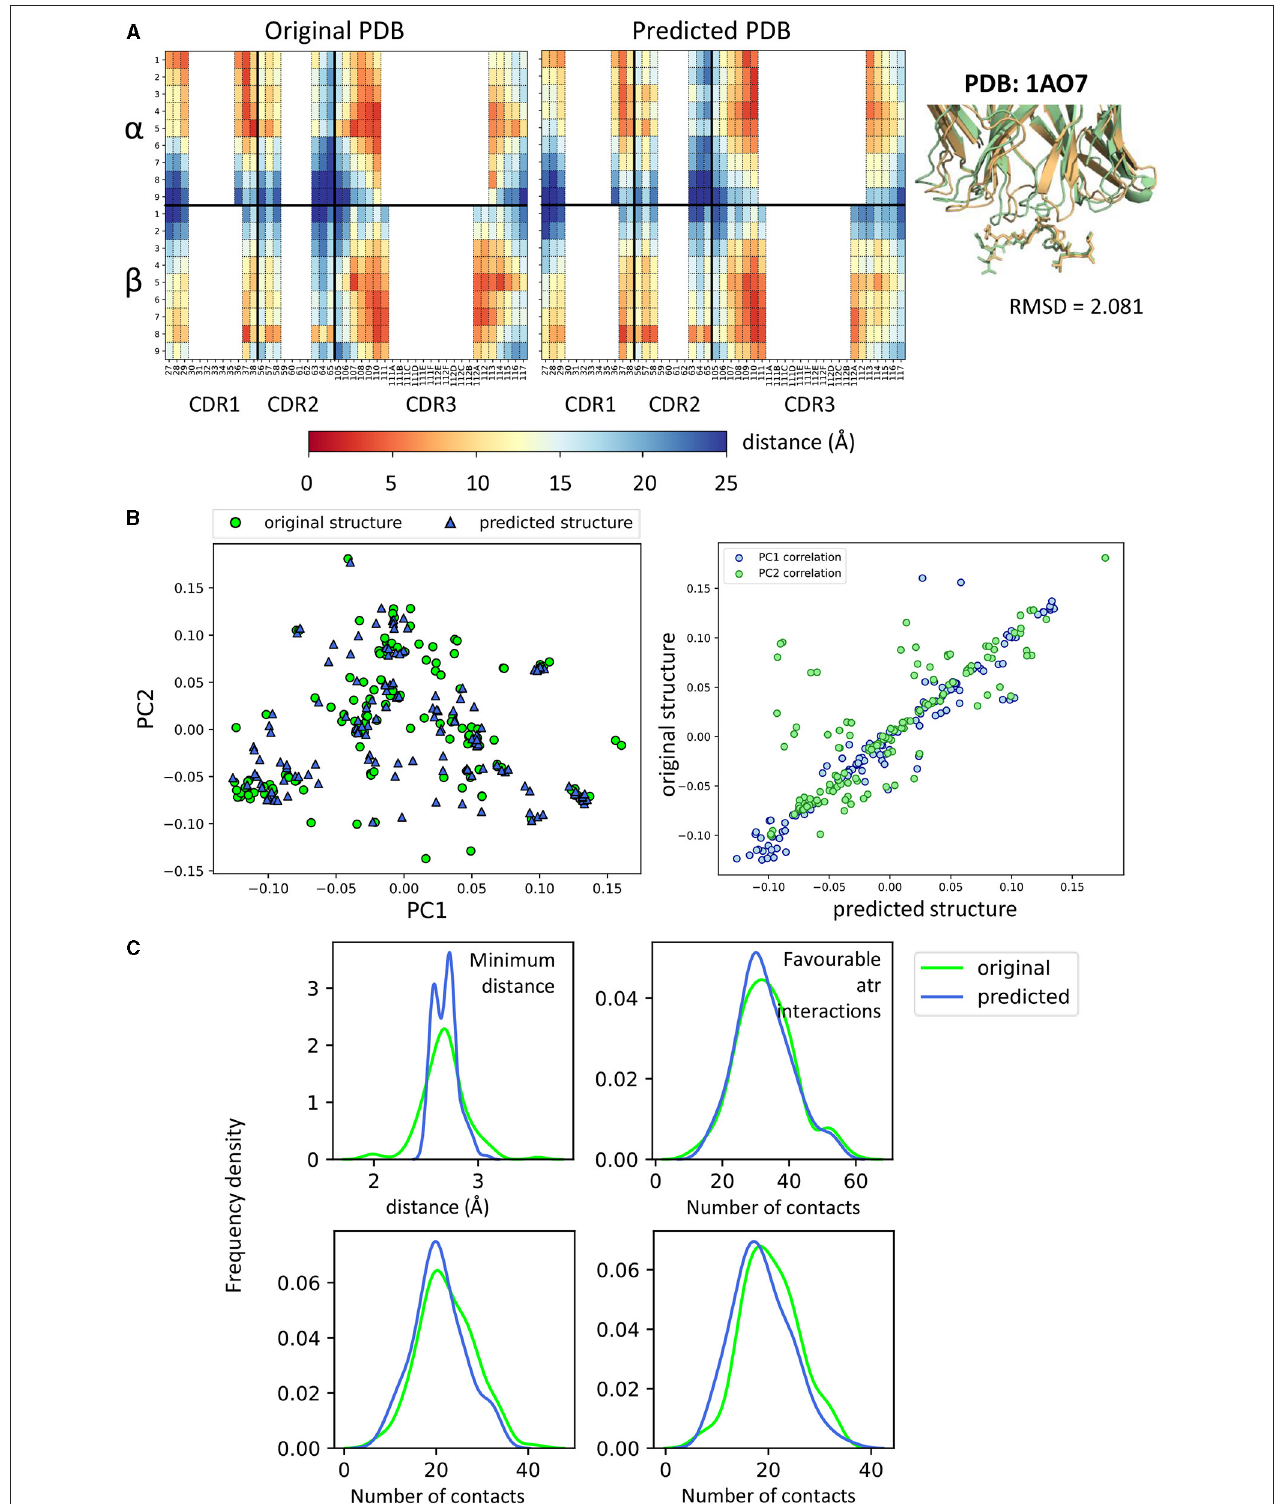
FIGURE 4 | Comparisons between crystal structures and homology predicted structures. (A) Comparison of fingerprint between the original 1AO7 structure and the one predicted by TCRpMHCmodels. On the right, figure showing how the two structures superimpose in cartoon form (green = original, gold = predicted). MHC not